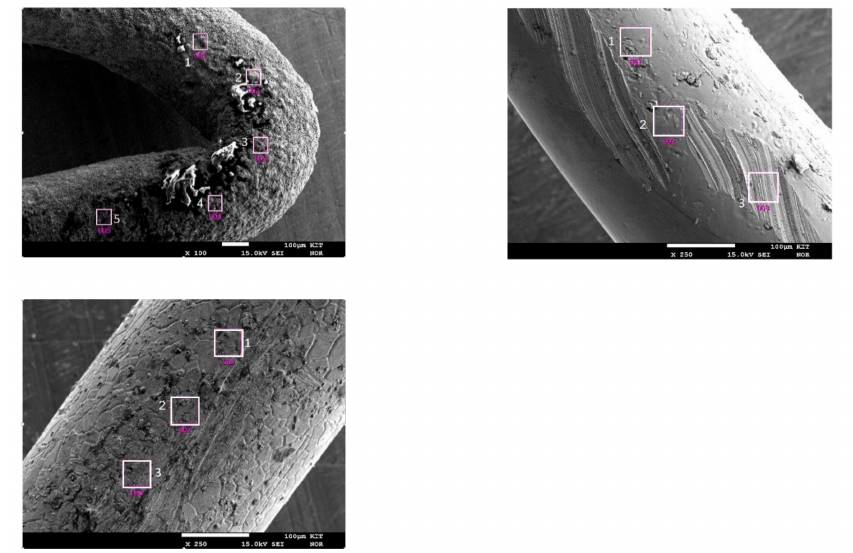
Figure 9. EDX-measurements of thermocouple tip ( top left ), Pt-wire ( top right ) and Pt / 10 Rh-wire ( below ).